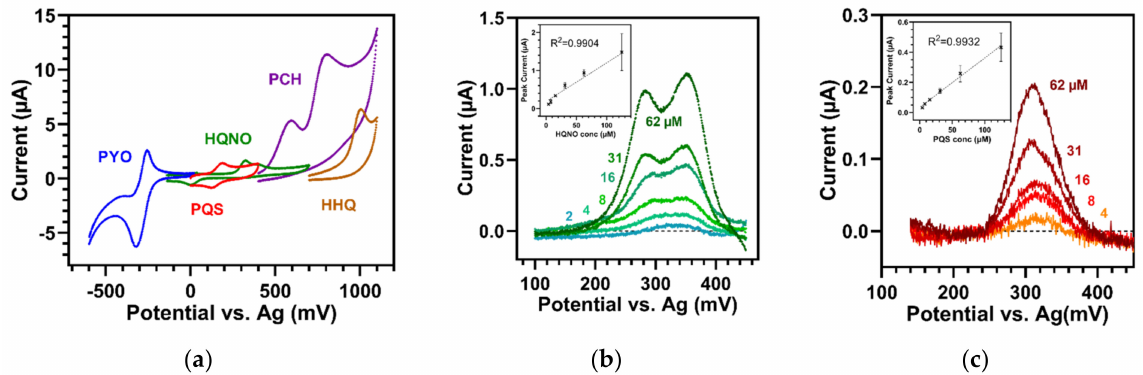
Figure 6. ( a ) Position of the main peaks of PYO (62 µ M), PQS (250 µ M), HQNO (250 µ M), PCH (62 µ M), and HHQ (62 µ M) in CV (100 mV/s, buffer of pH 6.4). Concentrations with pronounced signals are used for comparison. ( b , c ) Square wave voltammograms (step size 0.5 mV, amplitude 50 mV, frequency 5 Hz) of HQNO in PMCN medium and of PQS in pH 3.8 buffer, respectively. Inserts: Calibration curves of peak currents. Error bars represent the standard deviations of triplicate